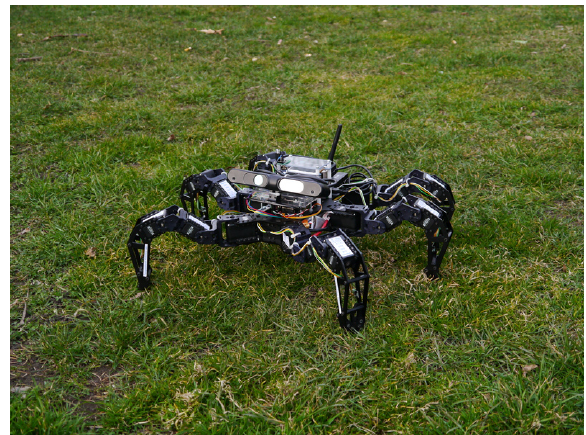
Figure 1. Hexapod walking robot